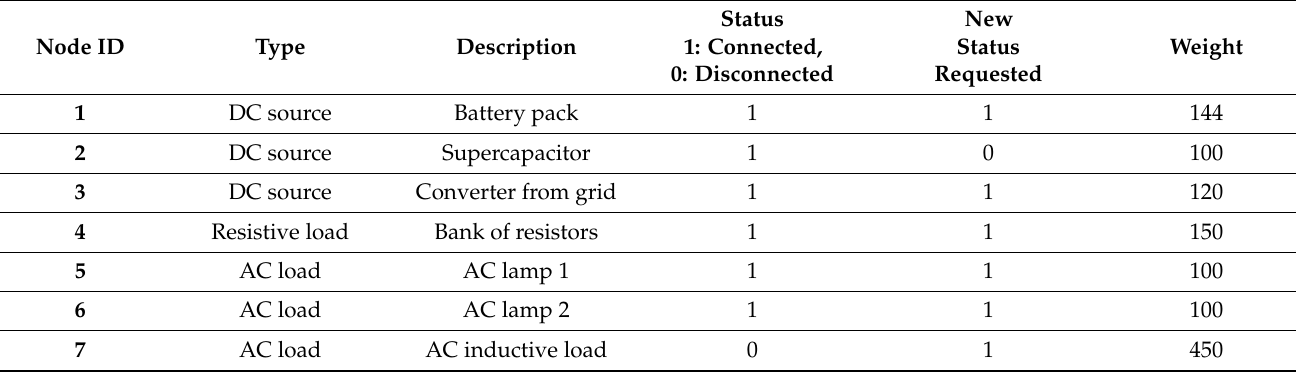
Table 7. Collected status of load and power